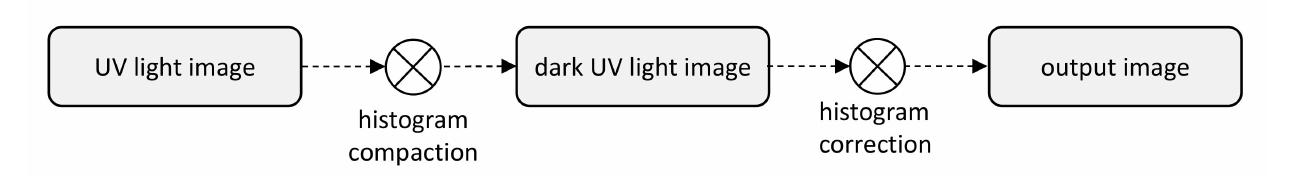
Figure 4. Setup of simplified static experiments using only UV light images (adapted from